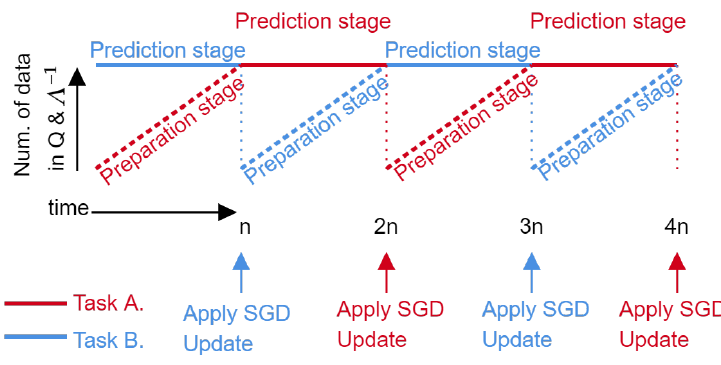
Figure 2. This figure shows how the tasks are scheduled for n = m case. When task A is in the preparation stage, task B is in the prediction stage to produce the predictive posteriors and accumulate the online meta-learning updates. When task B is in the preparation stage , task A is in the prediction stage to produce the predictive posteriors and accumulate the